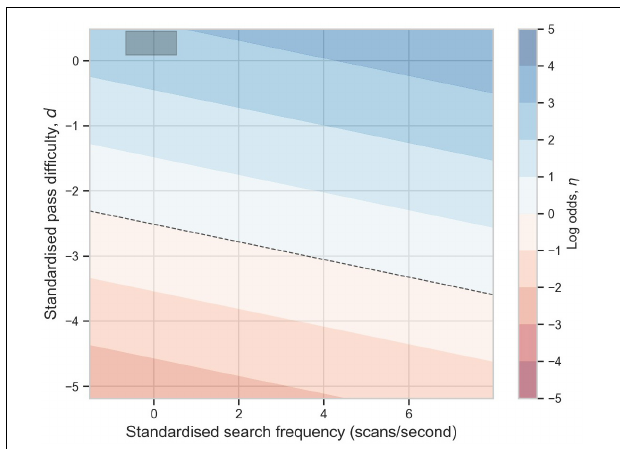
FIGURE 7 | Contour plot of the log-odds, η , plotted for different standardized values of the search frequency, v , and pass difficulty, d , using the coefficients µ α , µ β and γ (Eq. 3). The 25th and 75th percentile values for v and d are shown (dark gray shaded box). Probability of pass completion is ≥ 50% above and < 50% below the black dashed